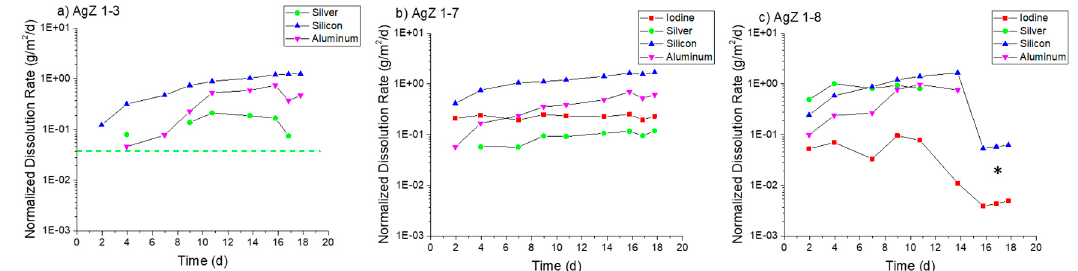
Figure 9. Normalized dissolution rates calculated from SPFT experiments using the AgZ samples at pH 11 for: ( a ) AgZ 1-3 (iodine-free sample); ( b ) AgZ 1-7; and ( c ) AgZ 1-8. The dashed lines, when present, represent the maximum rate for samplings where the analyte concentration was below the detection limit of the instrument and a dissolution rate calculated using the detection limit value. The asterisks (*) mark samplings where the flow rate deviated by >10% from the average flow of the test.